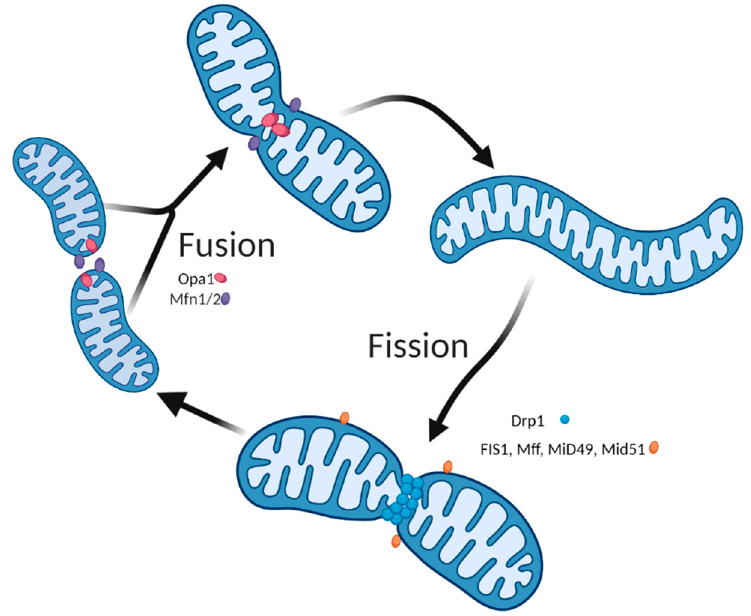
Figure 1. Mitochondrial dynamics. Mitochondria are highly dynamic organelles that can change their morphology through fusion and fission events. Fusion results in mitochondrial elongation (top section), whereas fission fragments mitochondria (bottom section). Mitochondrial fusion is controlled by Mfn1 & Mfn2 on the outer mitochondrial membrane and by Opa1 on the inner mitochondrial membrane. For mitochondrial fission to occur, cytoplasmic Drp1 is recruited on the mitochondrial outer membrane, where it binds to its adaptors, Mff, MiD49, and MiD51, causing a ring- or spiral-like structure around mitochondrial constriction sites. Created with BioRender.com.